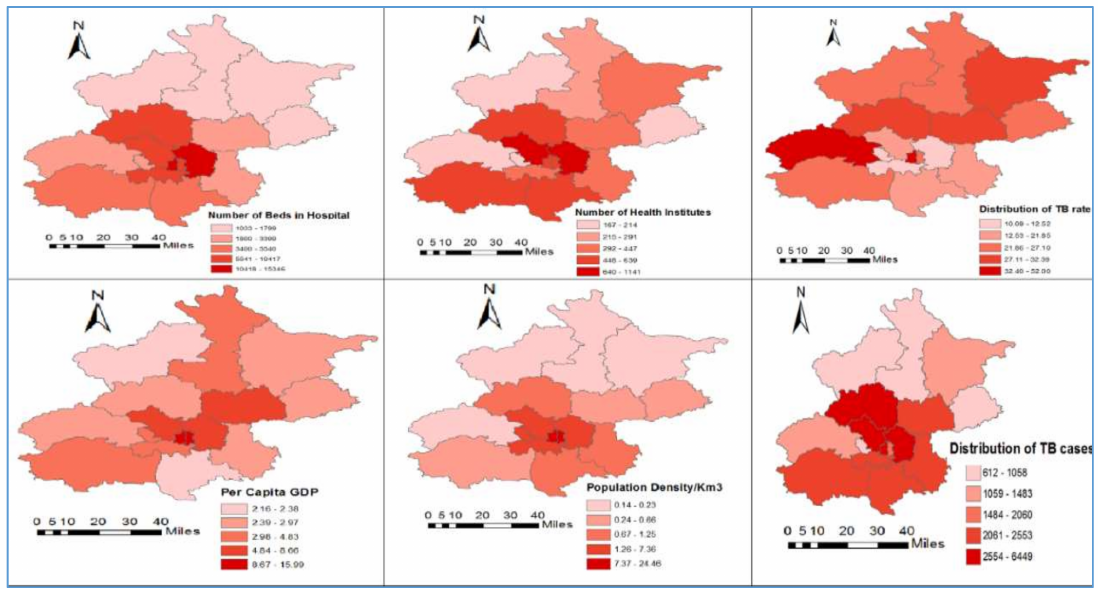
Table 1. Description of outcome and predictor variables.